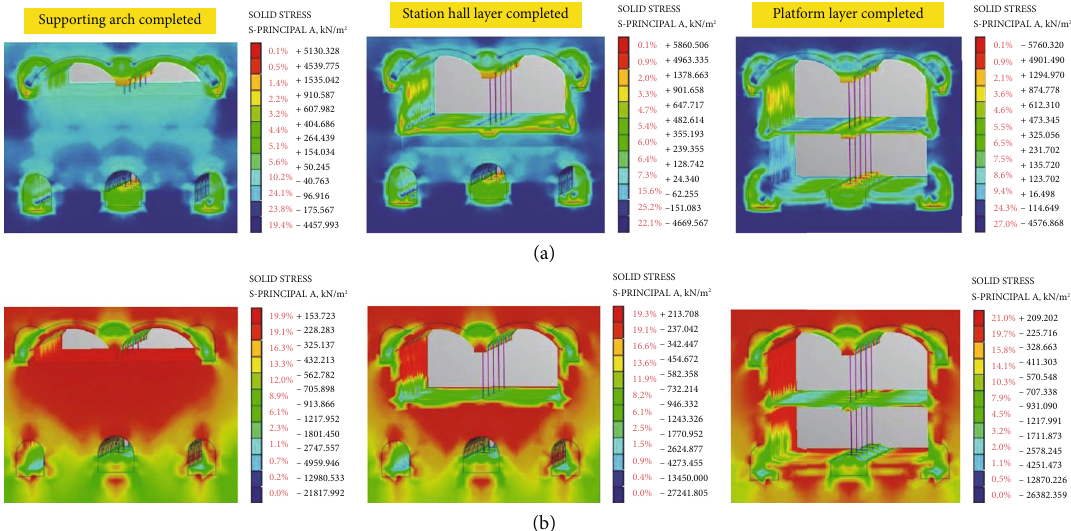
Figure 8: Stress contour of the upper bearing structure: (a) fi rst main stress and (b) third main